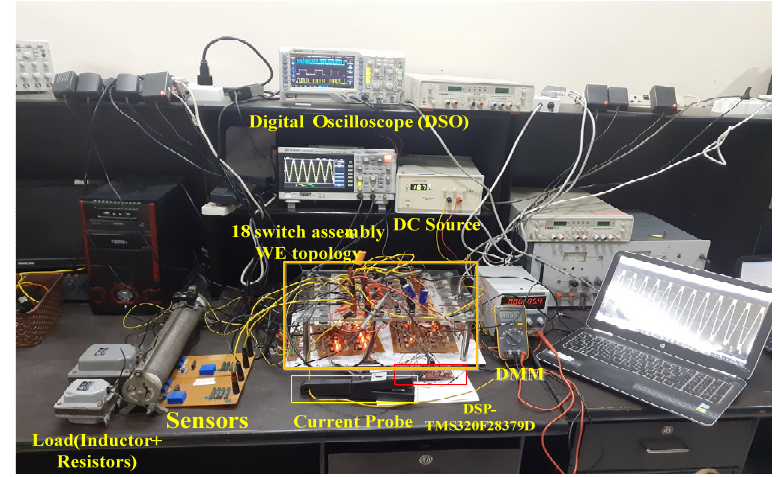
Figure 11. Hardware setup for experimental validation.